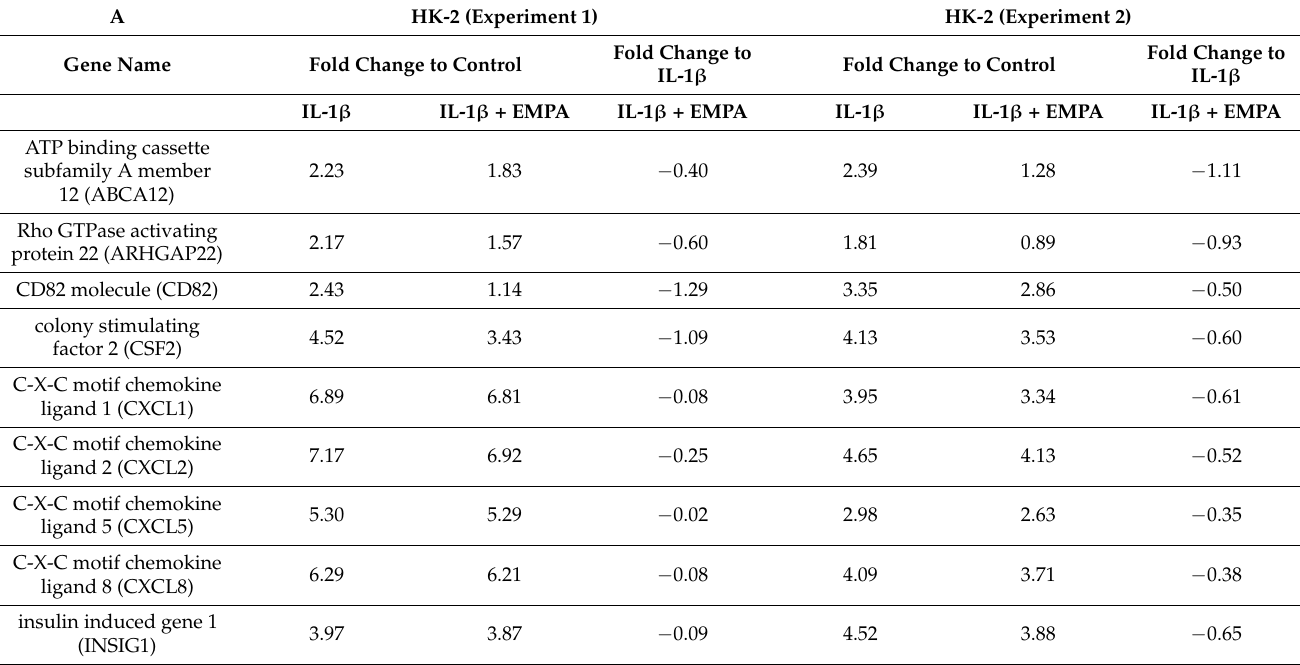
Table 1. Inflammatory response genes attenuated by empagliflozin in two independent human proximal tubular cell lines, namely HK-2 (A) and RPTEC/TERT1